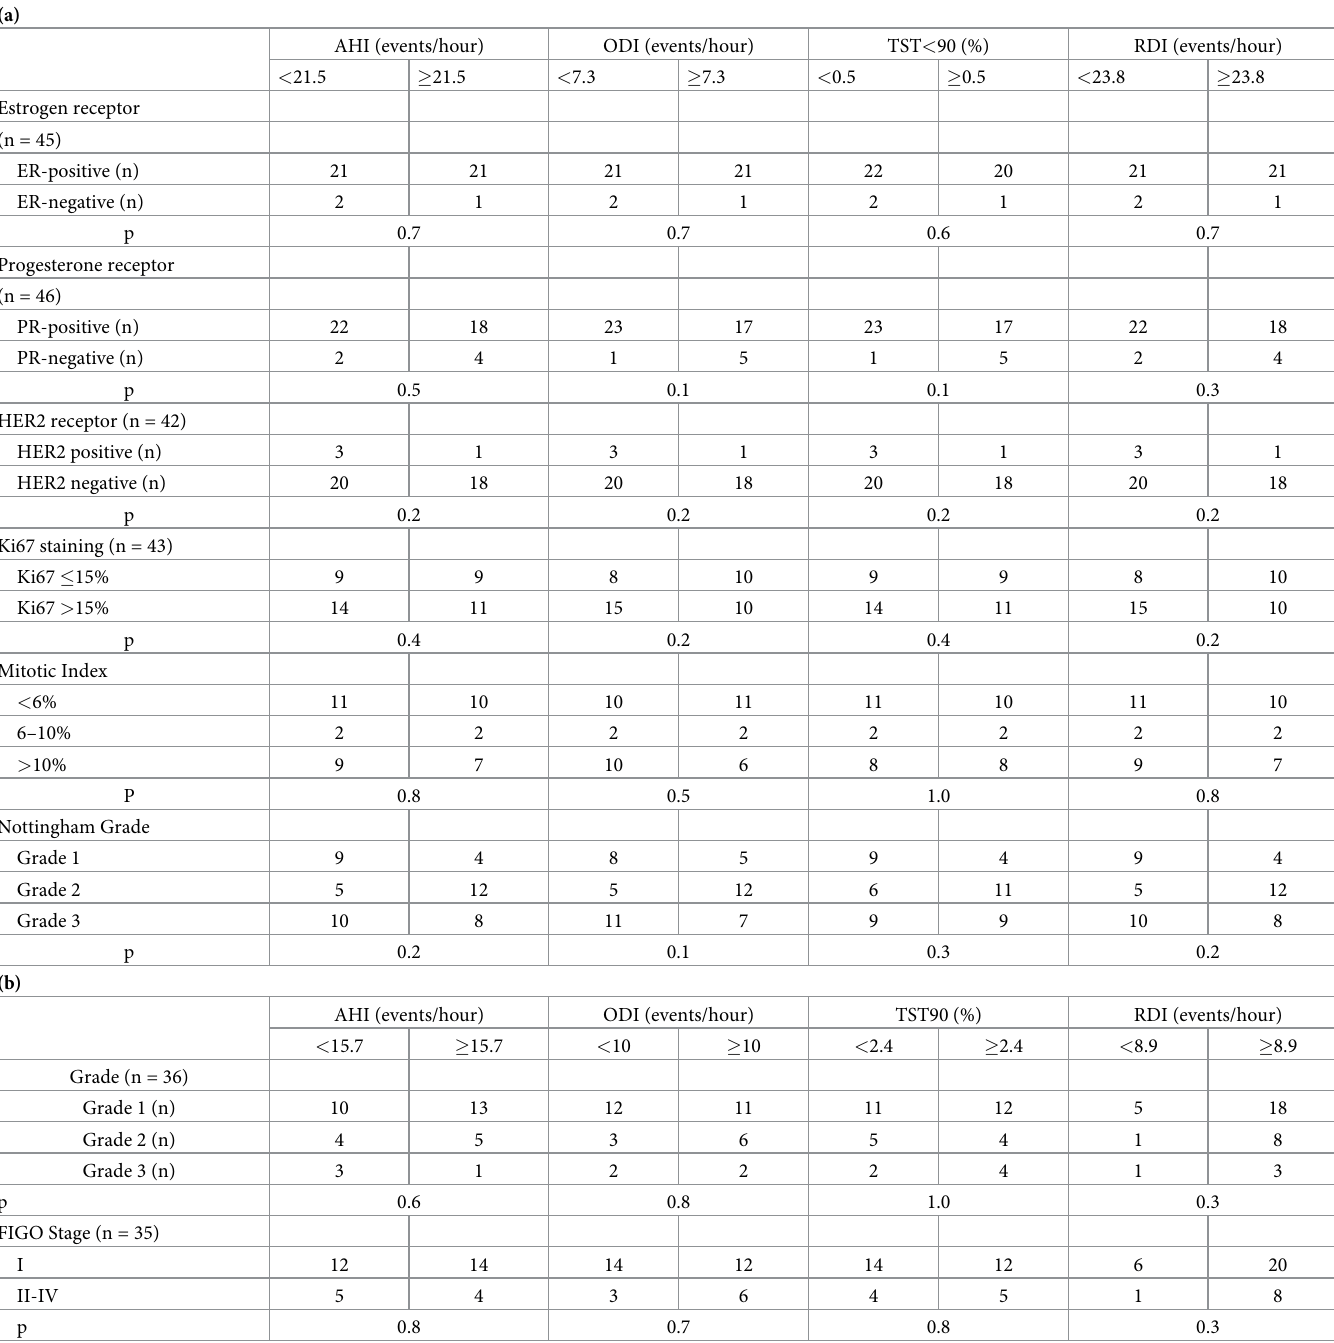
Table 4. Distribution of histopathological characteristics across the categorical variables for sleep disordered breathing for (a) breast cancer and (b) endometrial cancer.